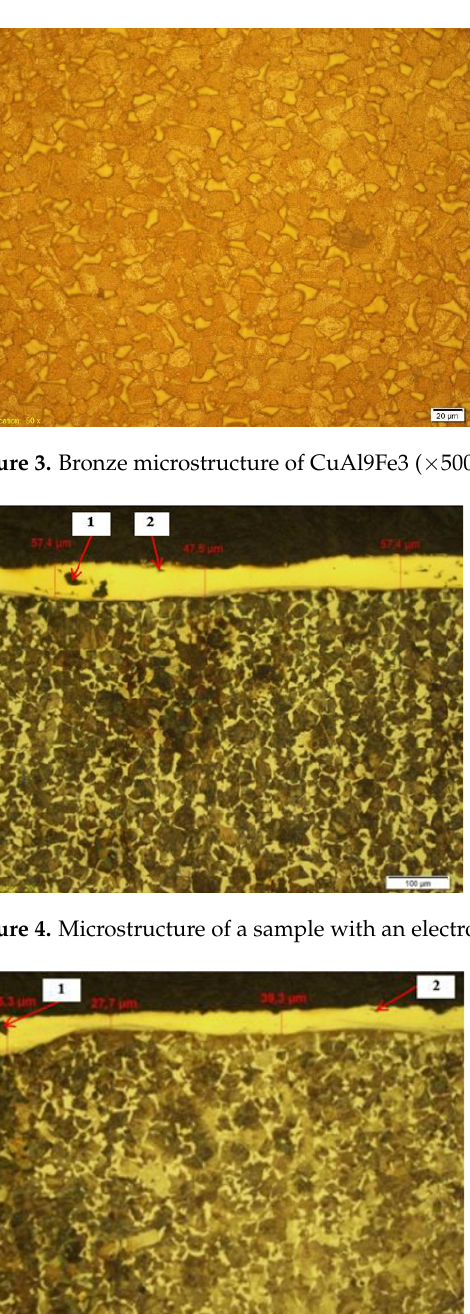
Figure 2. Microstructure of the forged SPS bronze (×500).